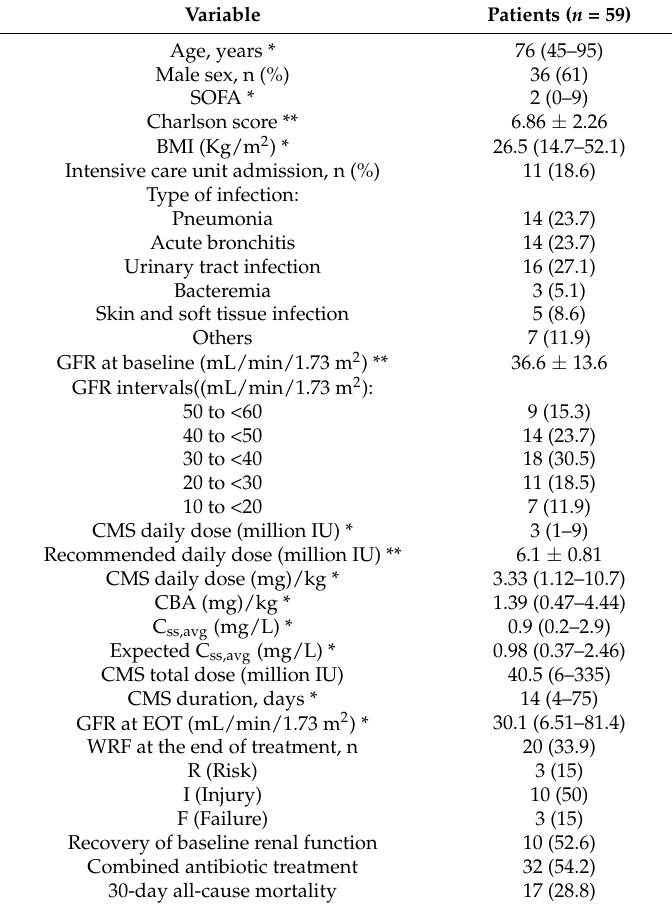
Table 1. Patients’ clinical, demographic and pharmacokinetic characteristics.